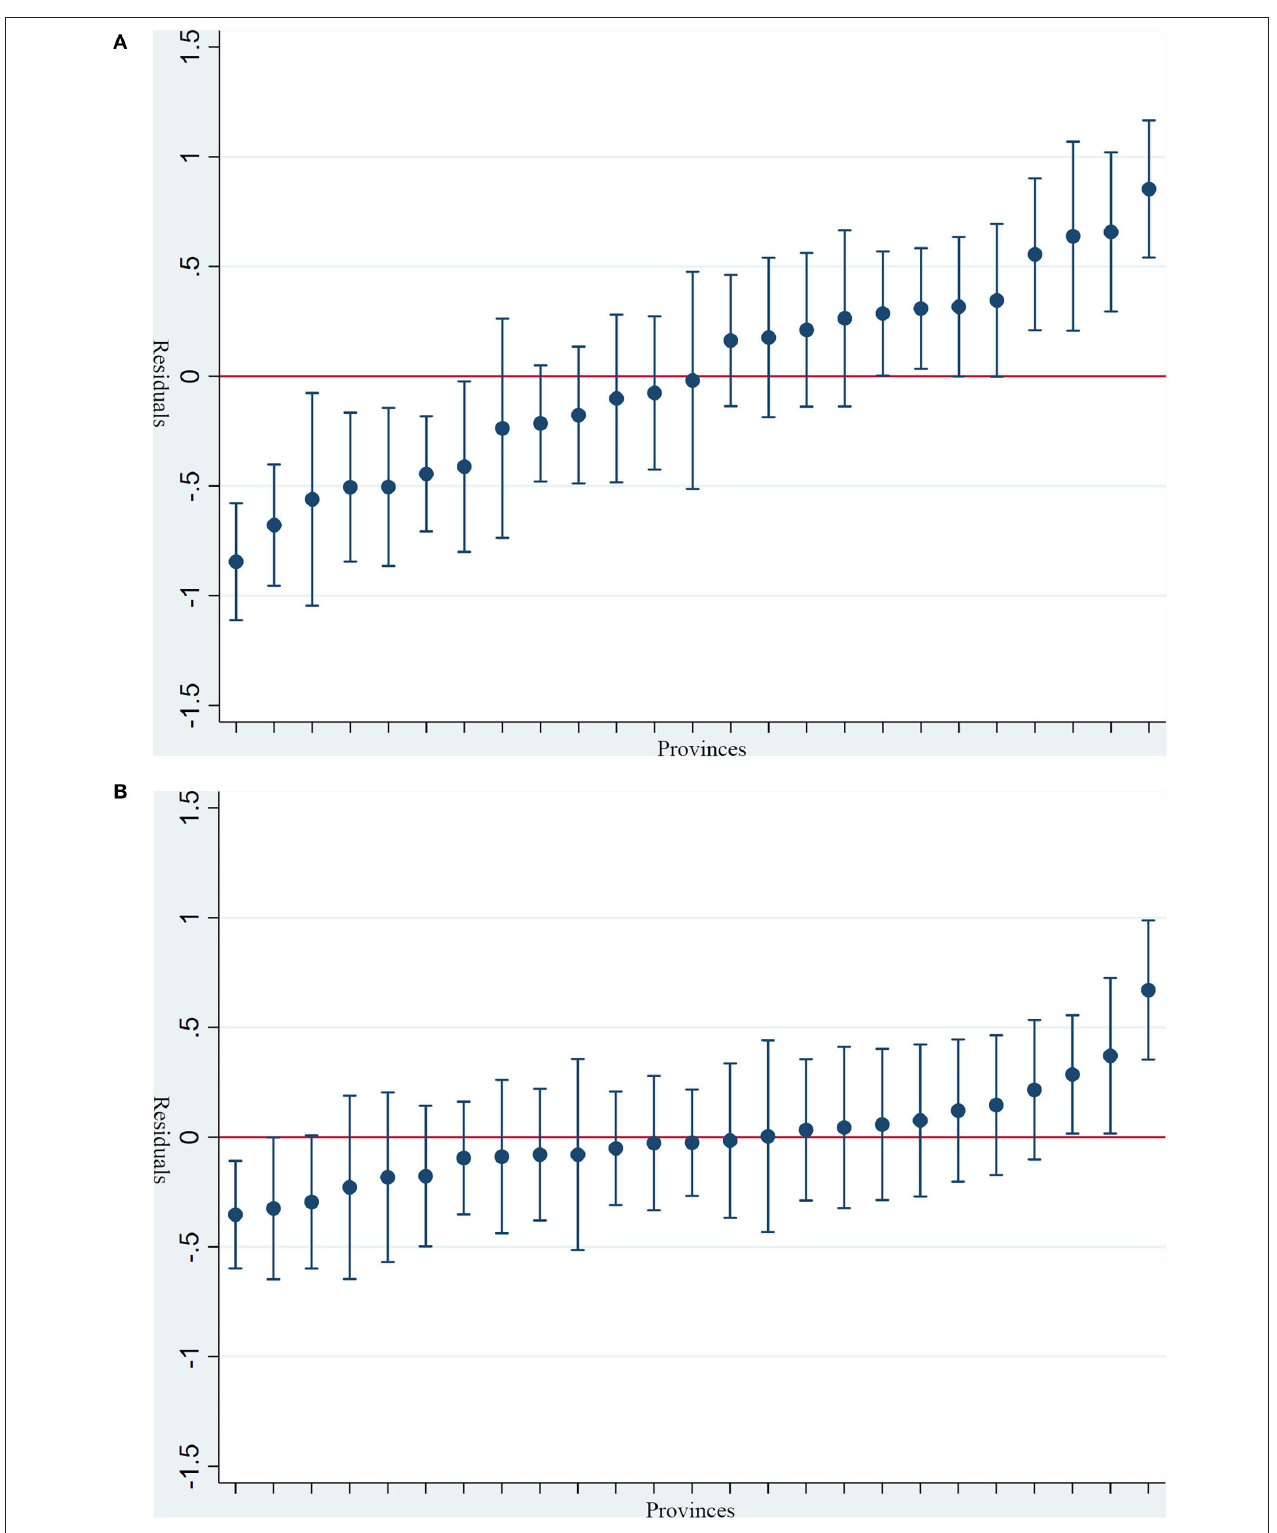
FIGURE 1 | (A) Caterpillar plot of provinces residual and ∼ 95% CIs vs. ranking (after controlling the individual-level characteristics; sequencing from left to right: Sichuan, Shandong, Shanghai, Zhejiang, Jiangsu, Henan, Liaoning, Tianjin, Hebei, Heilongjiang, Hubei, Anhui, Beijing, Yunnan, Jilin, Guangxi, Fujian,